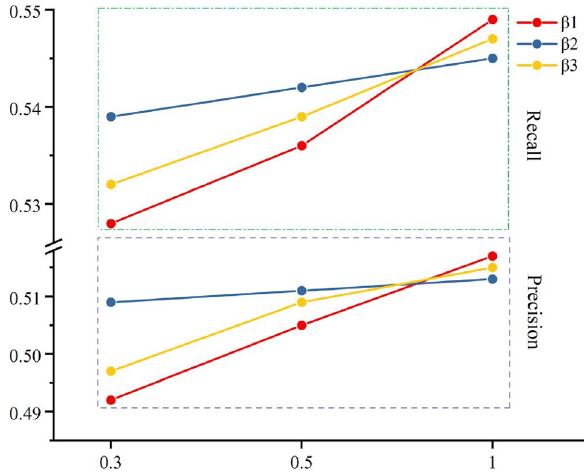
Figure 9. Performance w.r.t. different hyper-parameters β 1 , β 2 , β 3 .